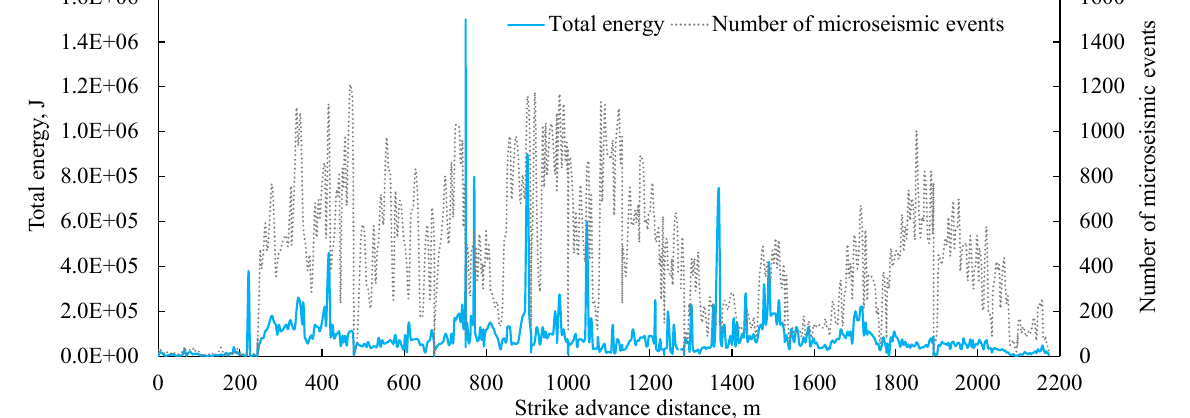
Since intense MIP events occurred during the mining of Working Faces #205 and #206, microseismic monitoring was performed during the mining of Working Face #207. The results of the microseismic monitoring during the mining of Working Face #207 are shown in Figure 17. The horizontal axis represents the advancement of the working face, while the vertical axis represents the total energy of the microseismic events that occurred at Working Face #207 as well as their number. Although a few high-energy events did occur during the mining of Working Face #207, no long-distance MIP events occurred. As a whole, the microseismic events were frequent but weak.